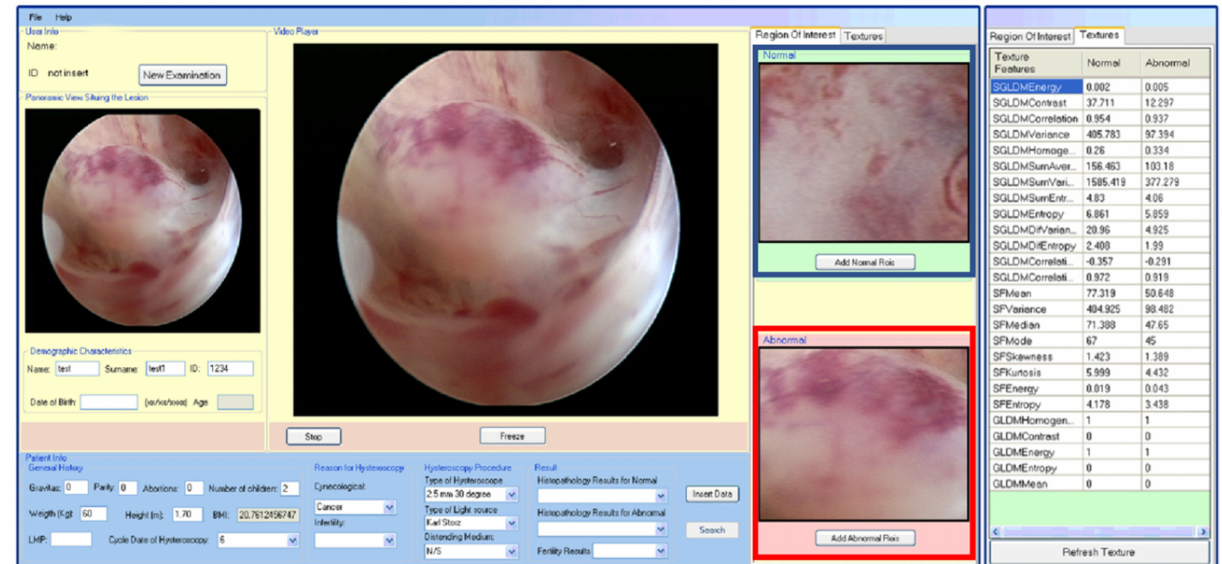
Figure 1. Illustration of a screenshot of a CAD system demonstrating video freezing and ROI selection and cropping, as well as the tabulation of the corresponding texture features. Blue-colored boundary: normal ROI. Red-colored boundary: abnormal ROI